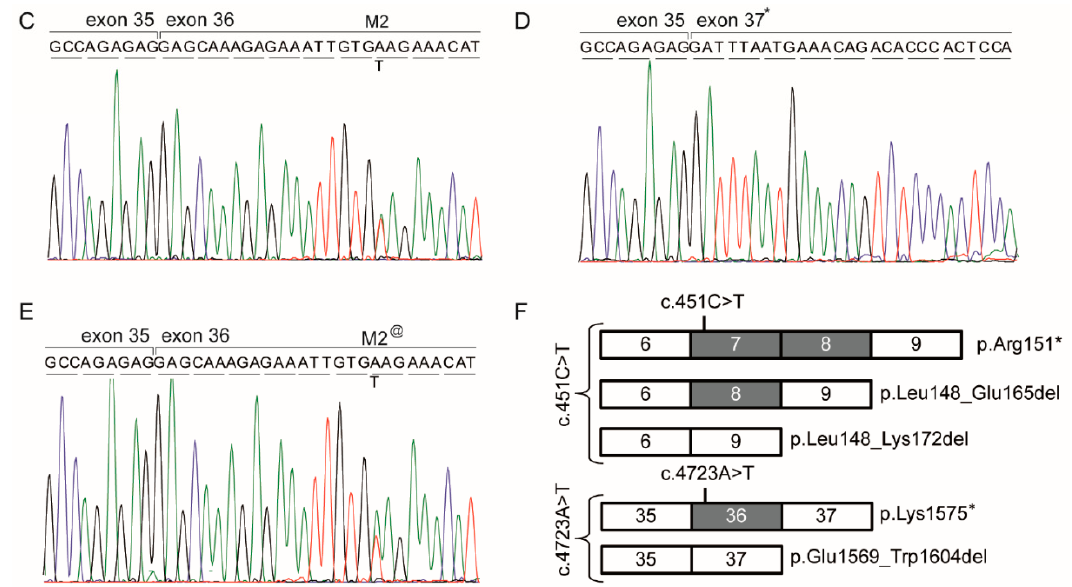
Figure 2. Pedigree and mRNA analysis of individuals with oligocone trichromacy (OT) carrying the heterozygous CEP290 variants c.4723A>T and c.415C>T. ( A ) The pedigree with OT and the segregation of CEP290 variants c.415C>T (p.(Arg151*), (M1) and c.4723A>T (p.(Lys1575*), (M2); ( B ) CEP290 cDNA analysis of the effect of the c.4723A>T variant on splicing of exon 36 in the patient cell